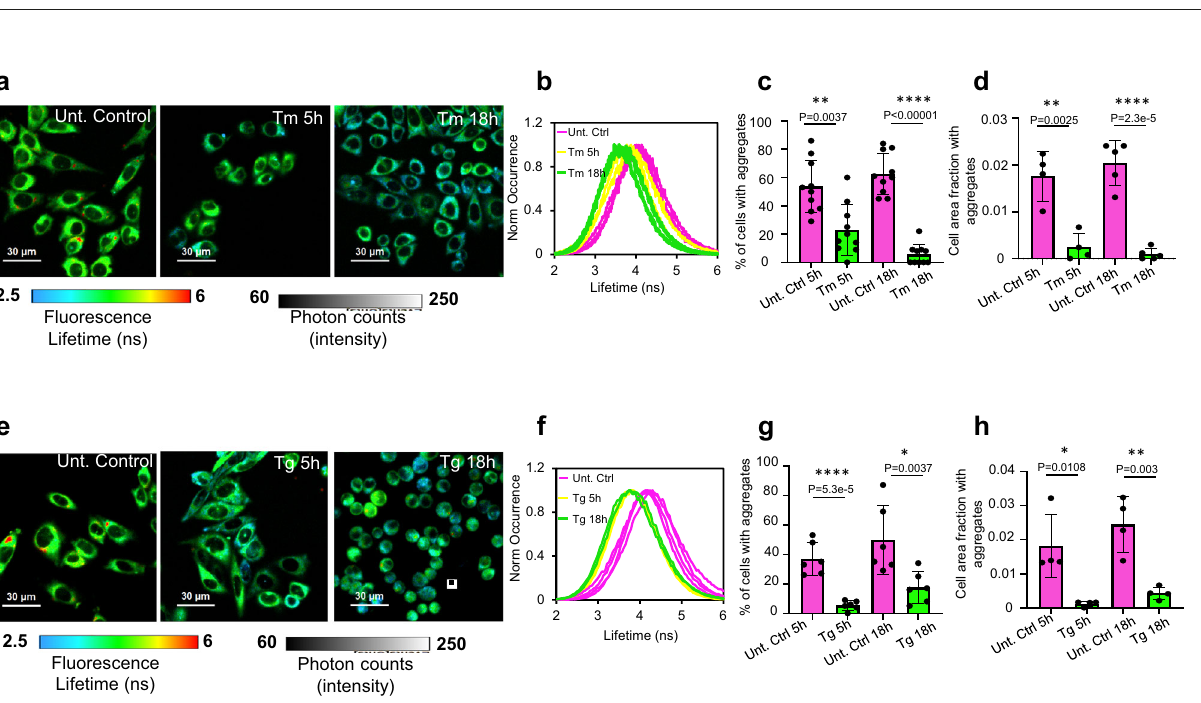
Fig. 2 Intra-ER accumulation of non-toxic aggregates of the metastable HT-aggr. a Time series of FLIM micrographs of CHO-K1 cells post stable retroviral infection with ER-targeted HT-aggr probe (K73T), labelled with P1 fl uorophore. ER-targeting of HT as in ref. 36 . b Plot of mean fl uorescence lifetime values of HT-aggr ER /P1 for the time points in ( a ). c Plot of the percentage of cells with FLIM-detectable aggregates (lifetime > 5 ns, apparent as red puncta, the threshold set to visualise aggregates in nearly monochromatic) from image-series as in ( a ). d Frequency distribution of aggregates ’ sizes extracted from FLIM time-series as in ( a ) using the Aggregates Detector, Icy algorithm. (shown in ( b , c ) are values of mean ± SEM, n = 7 independent fi elds of view with at least 20 cells each). e High-resolution fast 3D FLIM image projections of CHO-K1 cells with HT-aggr ER /P1. f FLIM images of live CHO- K1 cells stably expressing HT-WT ER or HT-aggr ER variants with various degrees of metastability, as indicated by Gibbs free energy values of unfolding ( Δ G 0 Unf ), ( h ) inset. g Plot of relative cell area occupied by FLIM-detected aggregates (lifetime > 5 ns, red puncta) quanti fi ed for the HT-aggr variants from images as in ( f ). (mean ± SEM, n = 3 independent fi elds of view, 60, 42, 55 and 45 cells analysed for WT, K73T, L172Q and M21K F86L variants, respectively). h Plot of relative cell area with aggregates (a measure of aggregation from ( g ) for each variant) as a function of its metastability, represented by the equilibrium constant of unfolding, expressed as K Unf = exp( − Δ G 0 Unf /RT) 21 , where Δ G 0 Unf is the free energy of unfolding (inset). i Growth curves for CHO-K1 cells expressing the HT-aggr ER variants (WT, cyan; K73T, yellow; L172Q, orange; M21KF86L, red) along with parental cells (magenta). Solid lines are the fi ts for the exponential growth according to the equation % conf t = % conf t0 2 (t/td) , where td is the doubling time. Individual values and standard deviations of td calculated from triplicates are shown in the inset. * P < 0.05; ** P < 0.01; *** P < 0.001; **** P < 0.0001, unpaired T test (two-tailed).